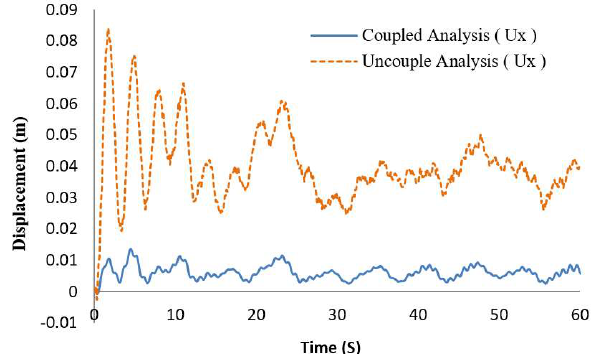
Figure 11. Comparison of displacements in the x-direction resulted from coupled and uncoupled analyses from the X-SEA program.